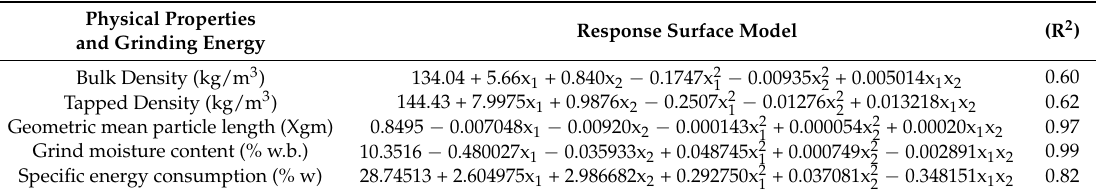
Table 4. The response surface models.